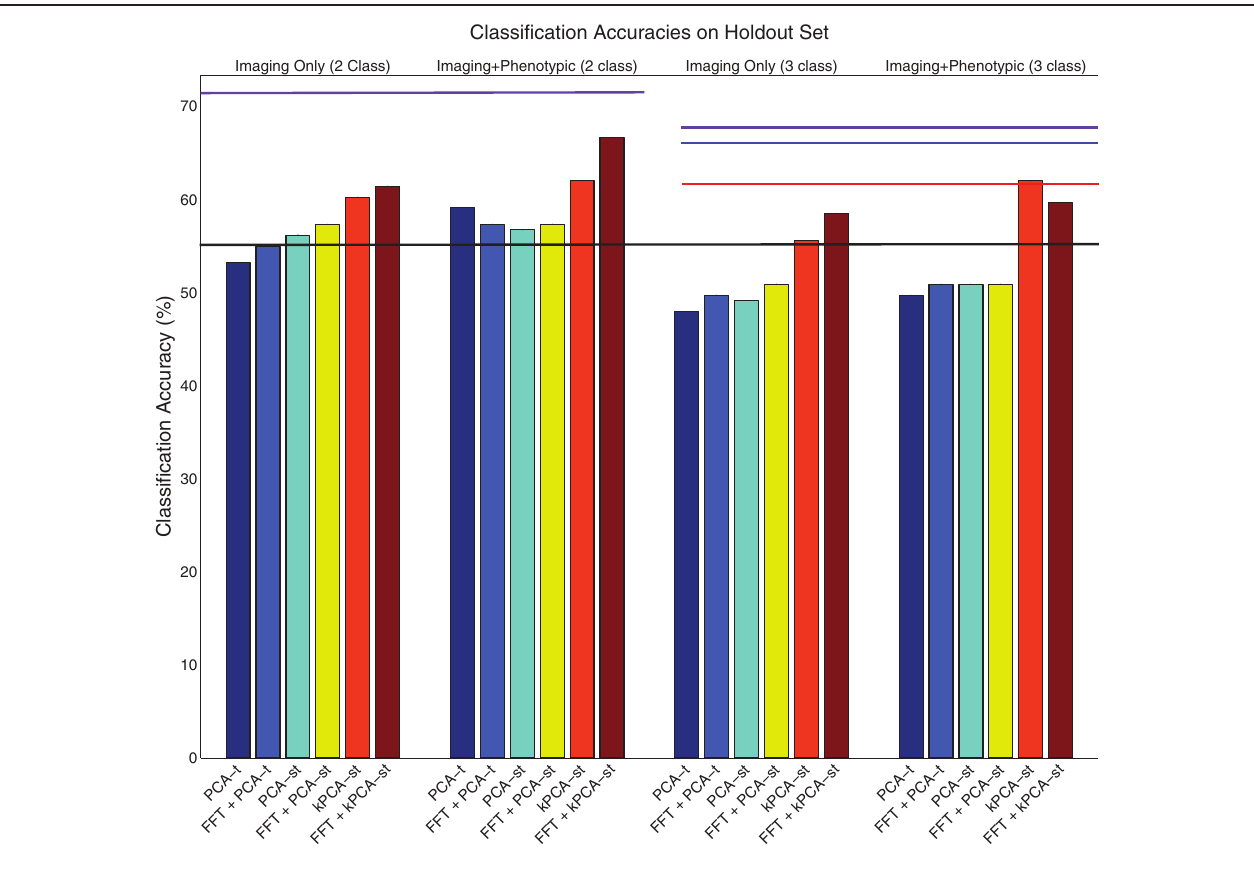
red line denotes the accuracy of the ADHD-200 global competition official winners’ submission. The blue line denotes the accuracy of our competition submission using the logistic classifier with phenotypic data